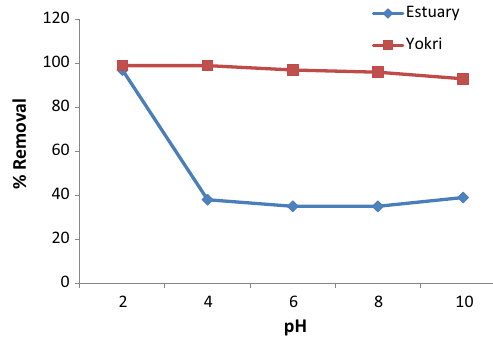
Fig. 5 Effect of concentration on sorption of crude oils onto FBPC Fig. 6 Effect of pH on the sorption of crude oils onto